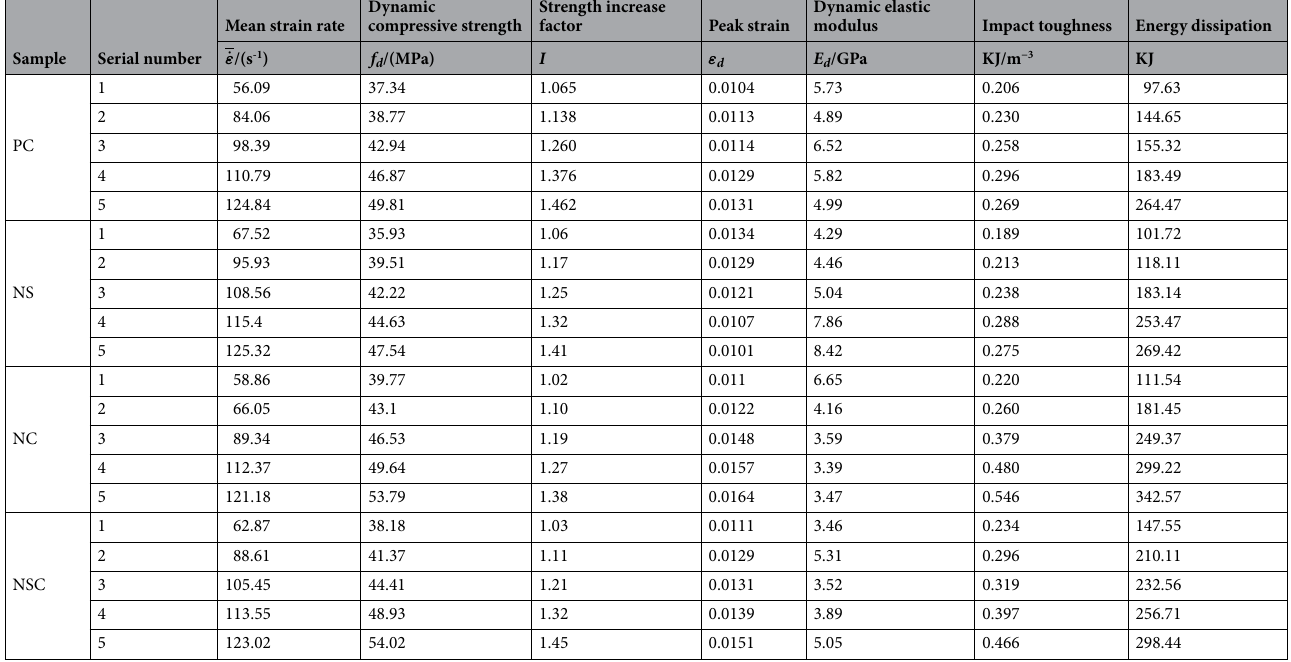
Table 6. SHPB test results of concrete.